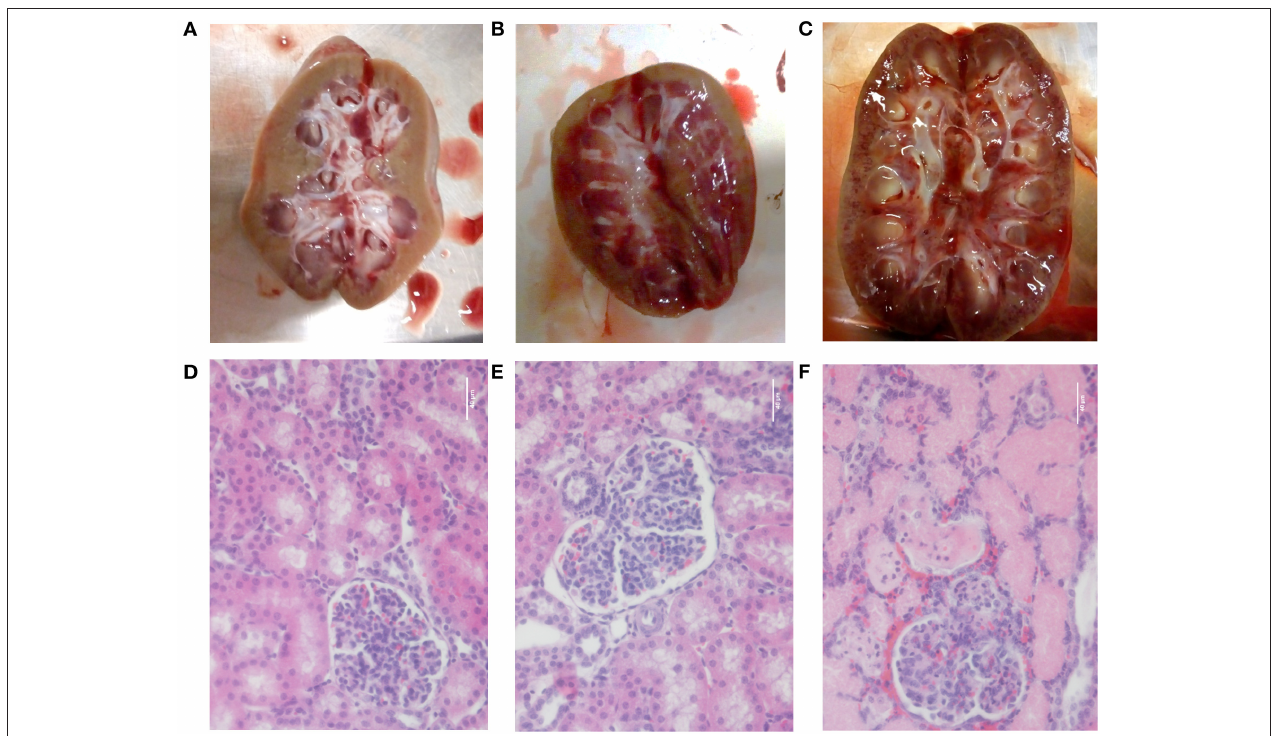
FIGURE 8 | Pictures of a longitudinal section of the kidney and after H&E staining (magnification 400 × ) of the renal cortex of the sham pig receiving saline (6 ml/kg/h) (A,D ), a pig receiving saline (6 ml/kg/h) in combination with a 5 µ g/kg/h LPS infusion (B,E) and the pig demonstrating a reduced renal function after 36h of saline infusion (6 ml/kg/h) in combination with 2 µ g/kg/h LPS (C,F) . Scale bar represents 40 µ